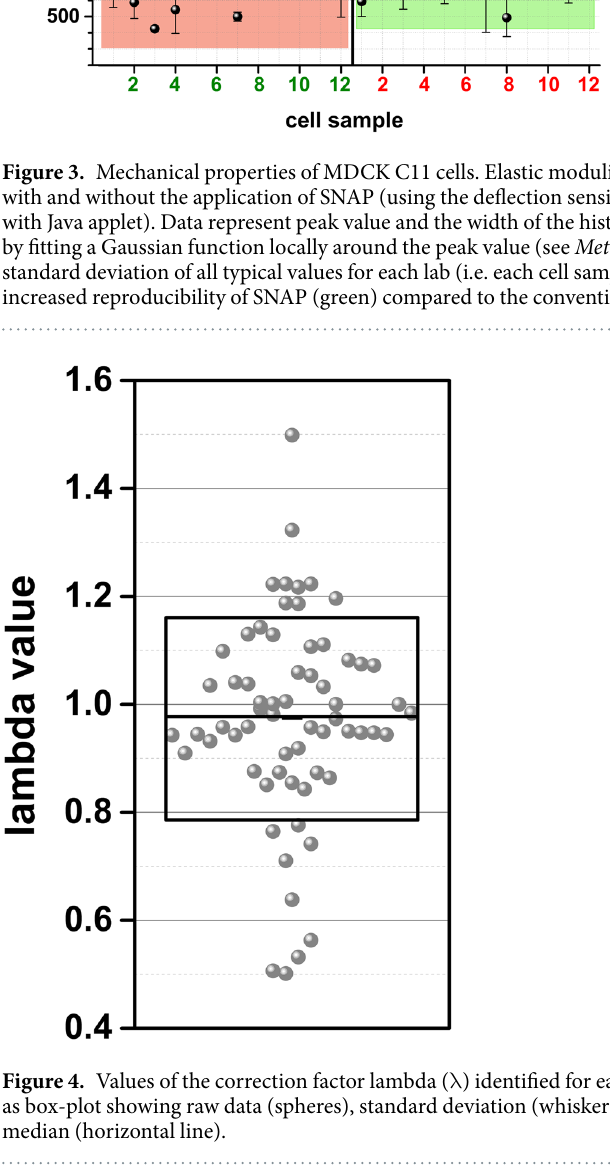
the variation between experiments is very large, the confidence of an individual measurement is much poorer. The consistency and reproducibility of data obtained applying SNAP is two times higher than data obtained with the conventional procedure, hence demonstrating the benefit of the proposed procedure. The correction factor lambda ( λ ) was identified for each applied SNAP (Fig. 4). The lambda value indicates the relative deviation of those calculated from the conventionally obtained deflection sensitivity and denotes its relative error directly ( λ 1.1 = 10% rel. error of deflection sensitivity). Figure 4 shows large variations of lambda with a mean of 0.97 and a standard deviation (SD) of 0.19 (n = 64). The data revealed that 98.4% (63) of all conventionally obtained values for the deflection sensitivity show errors, mostly in the range of 0–10% (34 out of 64) but nearly 50% in the range